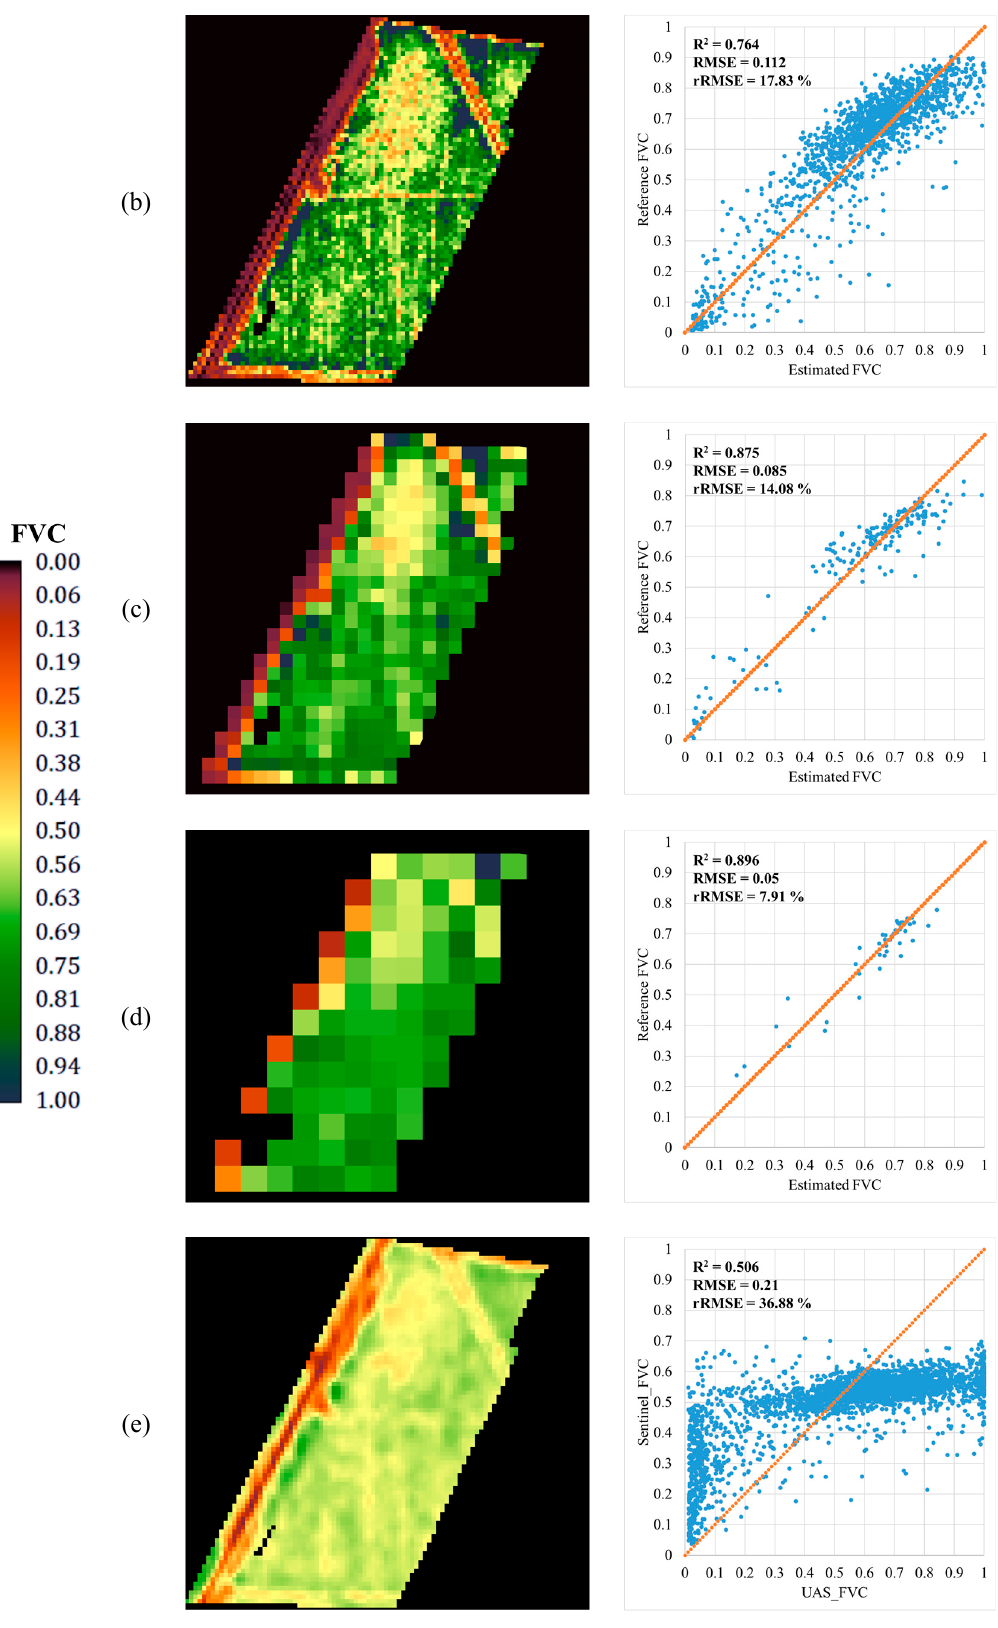
Figure 10. Estimated FVC from the UAS-based trained model for ( a ) 5 m ( b ) 10 m ( c ) 30 m and ( d ) 60 m. ( e ) The estimated FVC from Sentinel-2 data using the neural network method. The validation of the sentinel-based FVC is compared with ( b ).